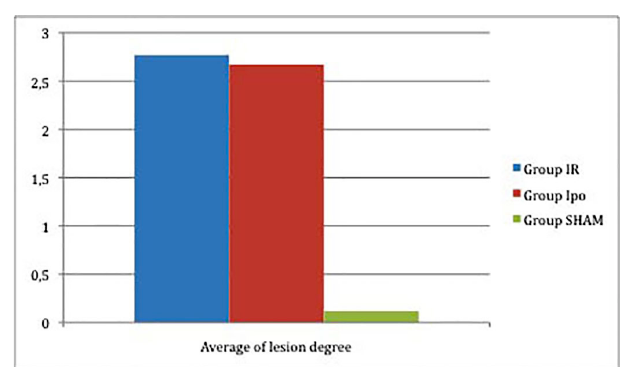
Fig. 2 - Results of the histological analysis of the injury degree of the intestinal mucosa of rats according to Chiu et al.